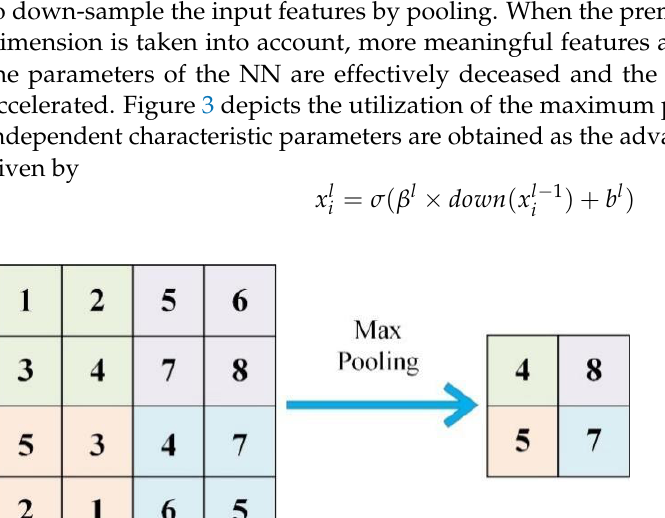
Figure 2. The schematic diagram of the convolution process.